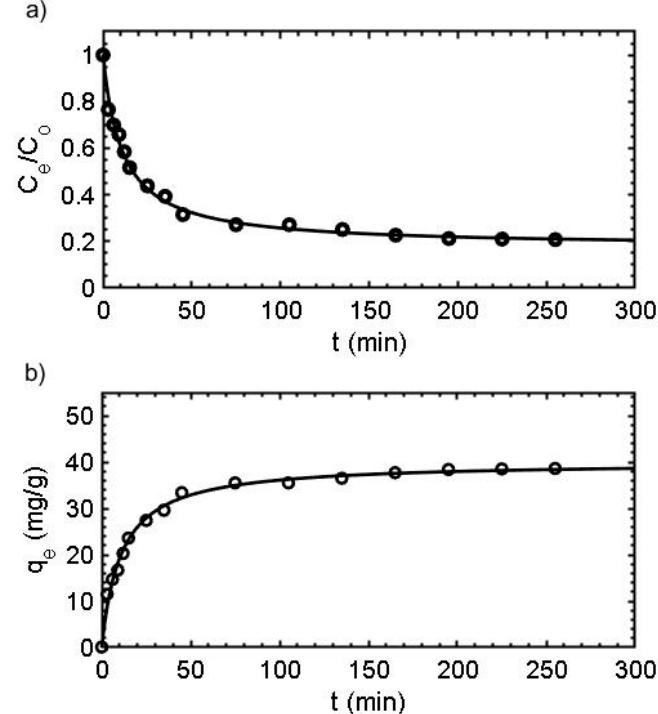
Figure 7. Kinetics isotherms: ( a ) Residual concentration vs. time, ( b ) adsorption capacity vs. time. (Solid line: pseudo-second order (PSORE) fit; Ci 50 mg/L; T: 25 °C, SD: 1 g/L; AS: 150 rpm; CT: 24 h; pHi: 4).